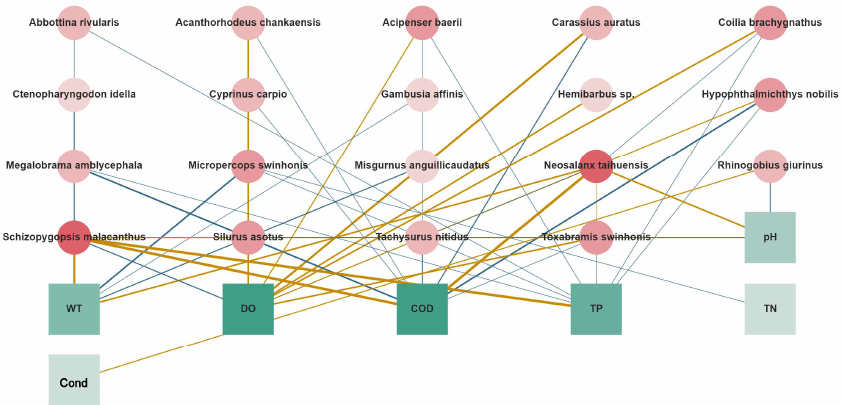
Figure 6. Network diagram of the correlation between environmental factors and fish communities. Pearson correlation analysis was conducted to characterize the correlations between environmental factors and the relative abundances of the top 22 species of fish. Among them, 19 species of fish were significantly correlated with environmental factors ( p < 0.05). The yellow lines represent significantly positive correlations, the blue lines represent significantly negative correlations, and the thickness of the lines represents the correlation, with thicker lines indicating a stronger correlation. The thickest line represents a strong correlation ( R > 0.7) and the thinnest line represents a moderate correlation ( R > 0.4).